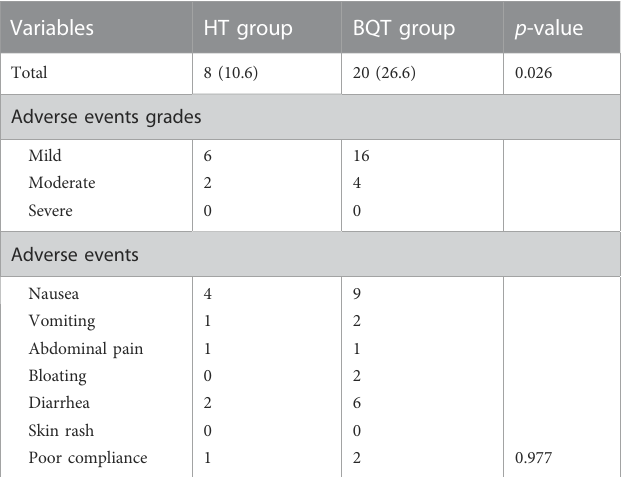
TABLE 3 Variety of adverse events in each